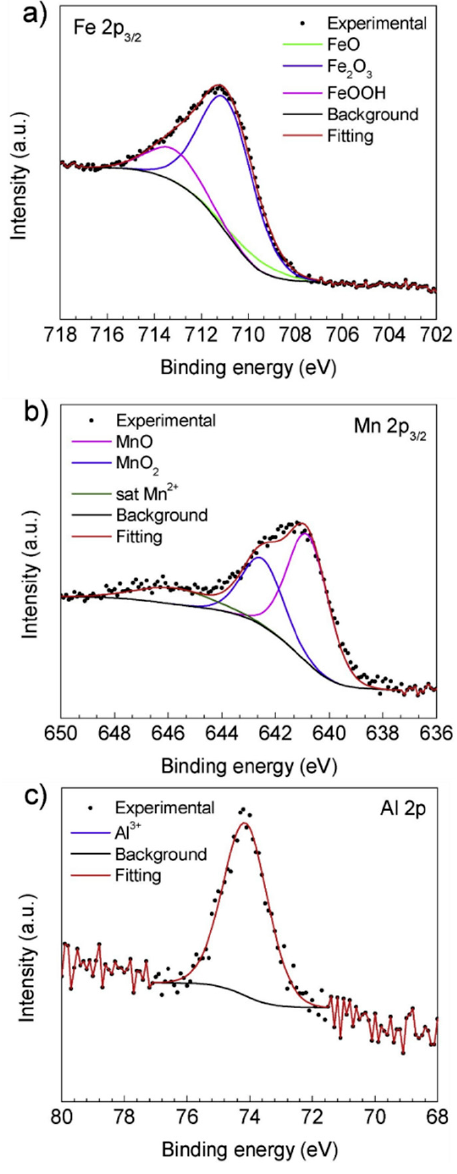
Figure 6. High-resolution XPS spectra for Fe − (21,25,28)Mn − 3Al − 5Si TWIP steels in 0.1M NaCl solution. ( a ) Fe 2p 3/2 , ( b ) Cr 2p 3/2 , and ( c ) Al 2p [83]. (Reproduced with permission from refs. [83]. Copyright (2019), Elsevier ).